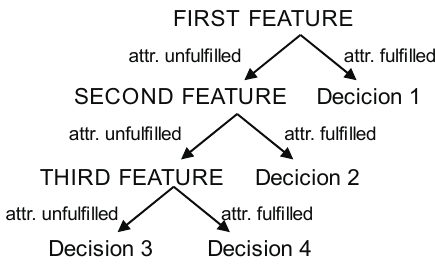
Figure 4. Decision tree diagram.